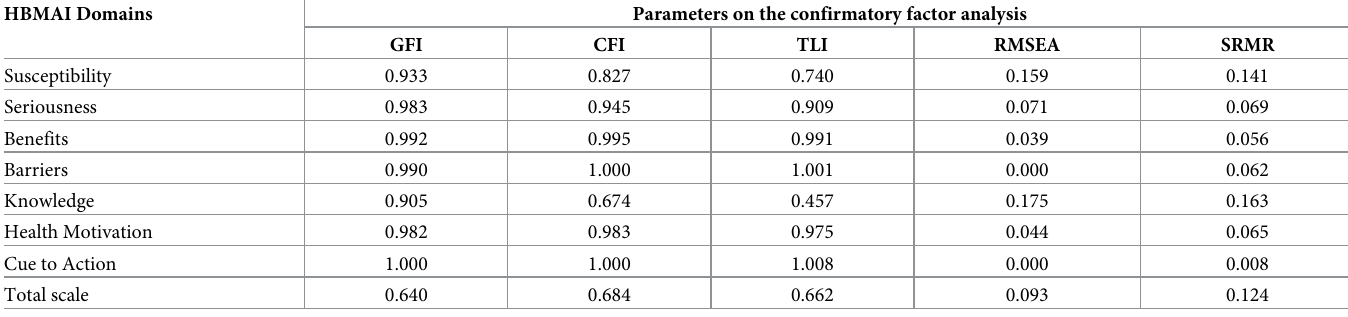
Table 1. Parameters of the confirmatory factor analysis of the original Health Belief Model Applied to Influenza (HBMAI) among people with chronic diseases in Serbian